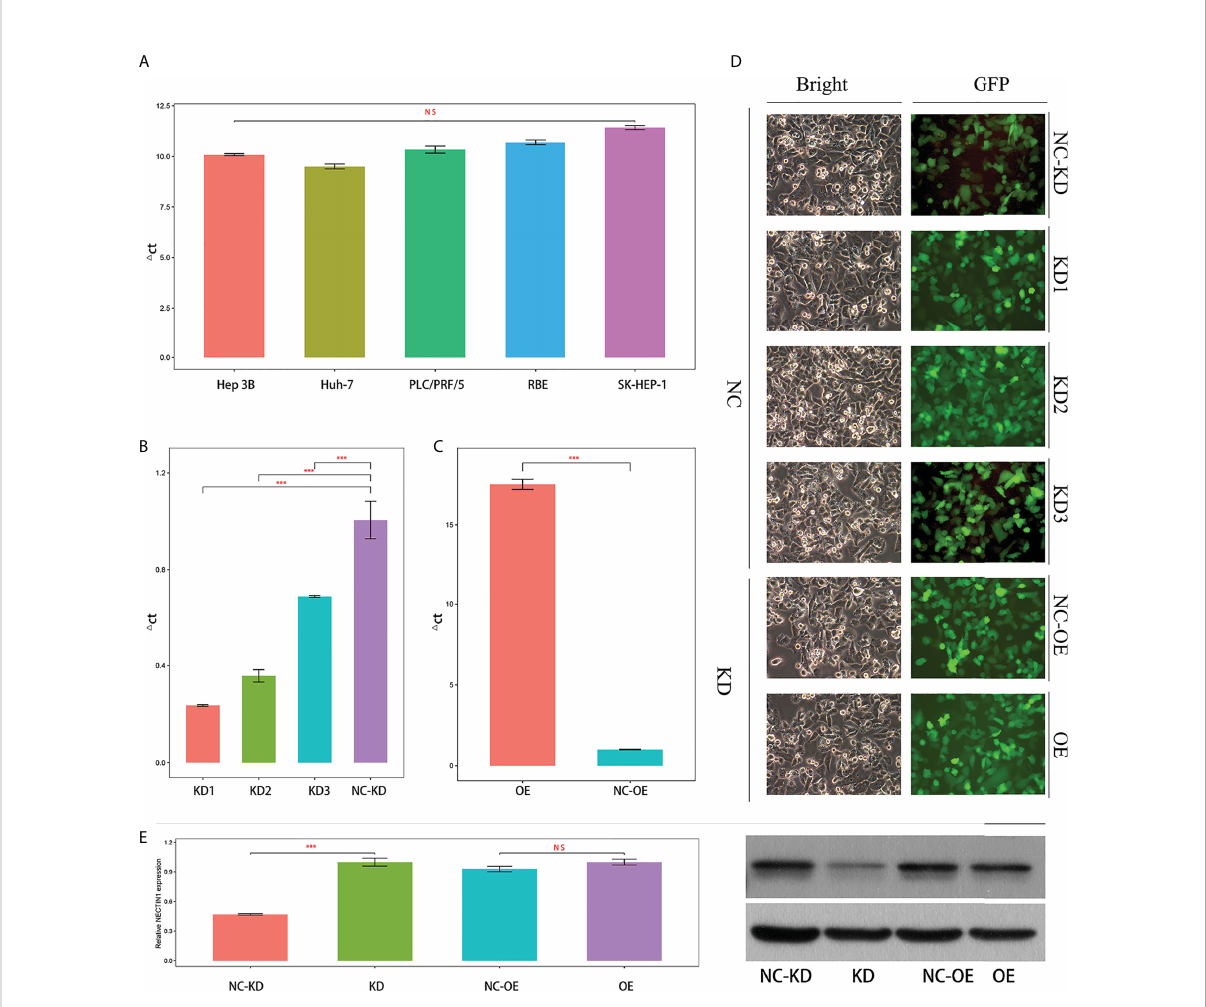
FIGURE 8 Expression and knockdown screening or overexpression of nectin-1 in the hepatoma cell line. (A) Expression of nectin-1 gene in different hepatoma cell lines. (B) Knockdown screening of lectin-1 RNA interference in hepatoma cell line. (C) Overexpression of nectin-1 gene in hepatoma cell line. (D) Expression of GFP in a hepatoma cell line (100×). (E) Protein expression after knockdown and overexpression of nectin-1 in the hepatoma cell line. ***P<0.01; ns, no signi fi